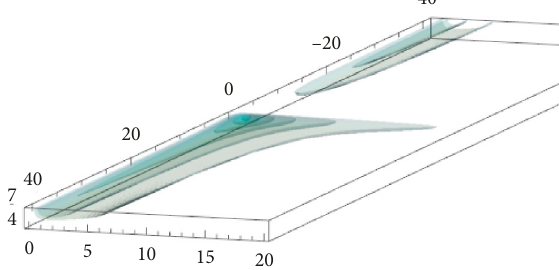
Figure 14: AdB 3 Dhalf − cut .